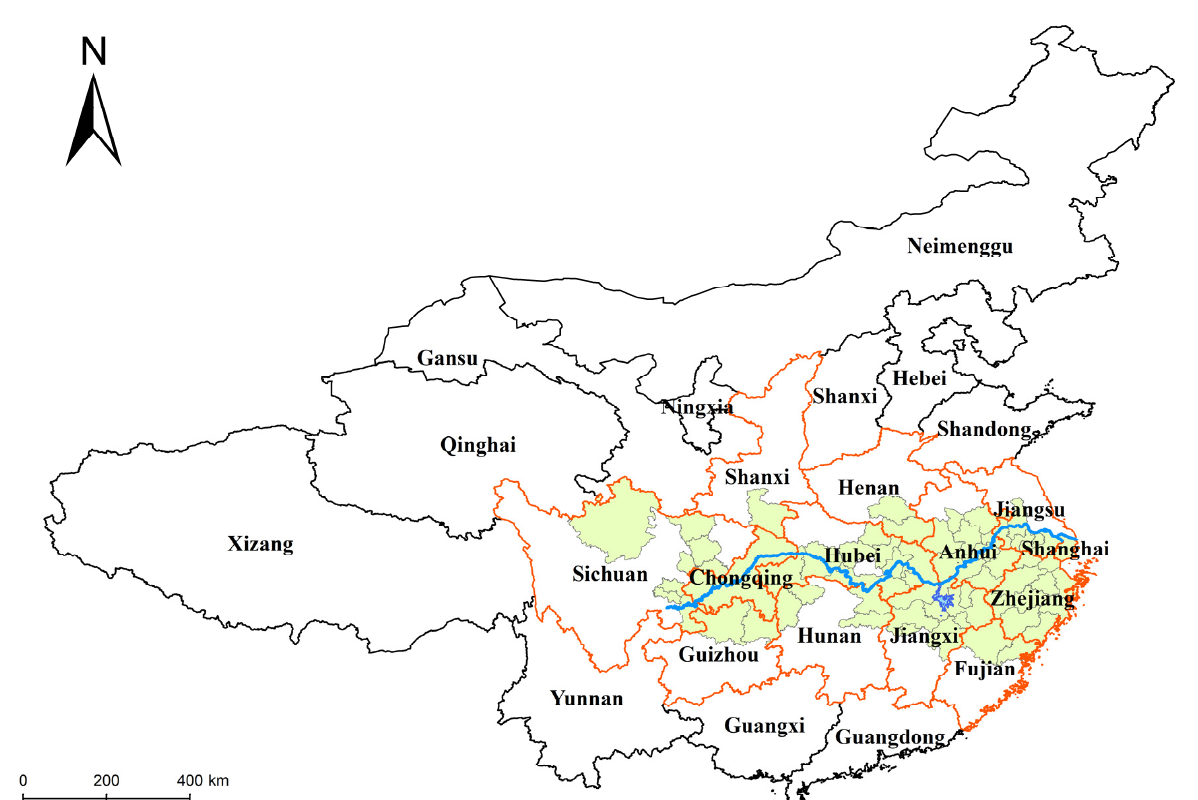
Figure 5. T he location of the affected areas. Figure 5. The location of the affected